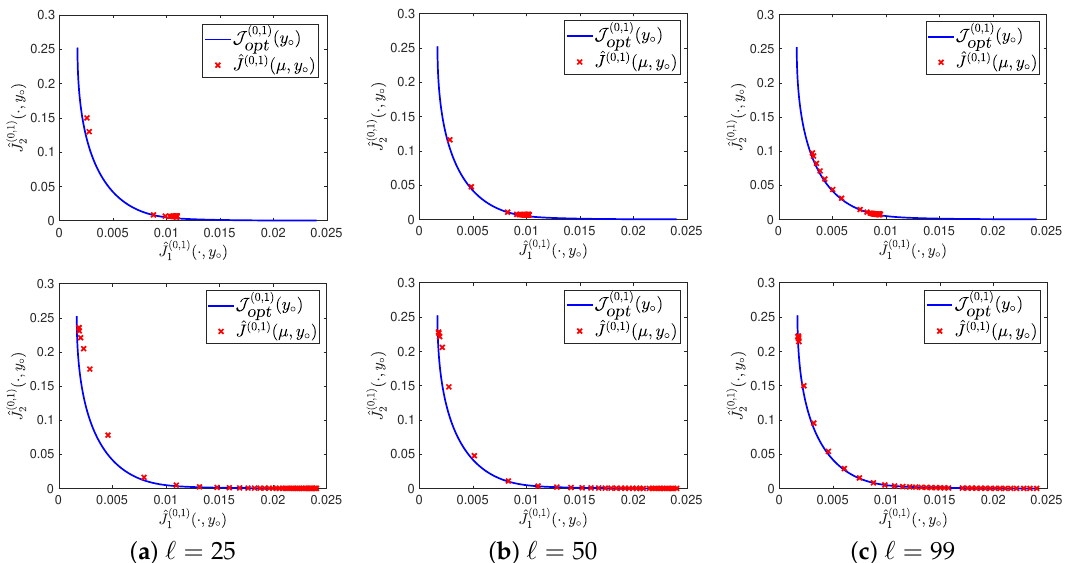
( y ◦ ) for different horizon lengths. opt,appr